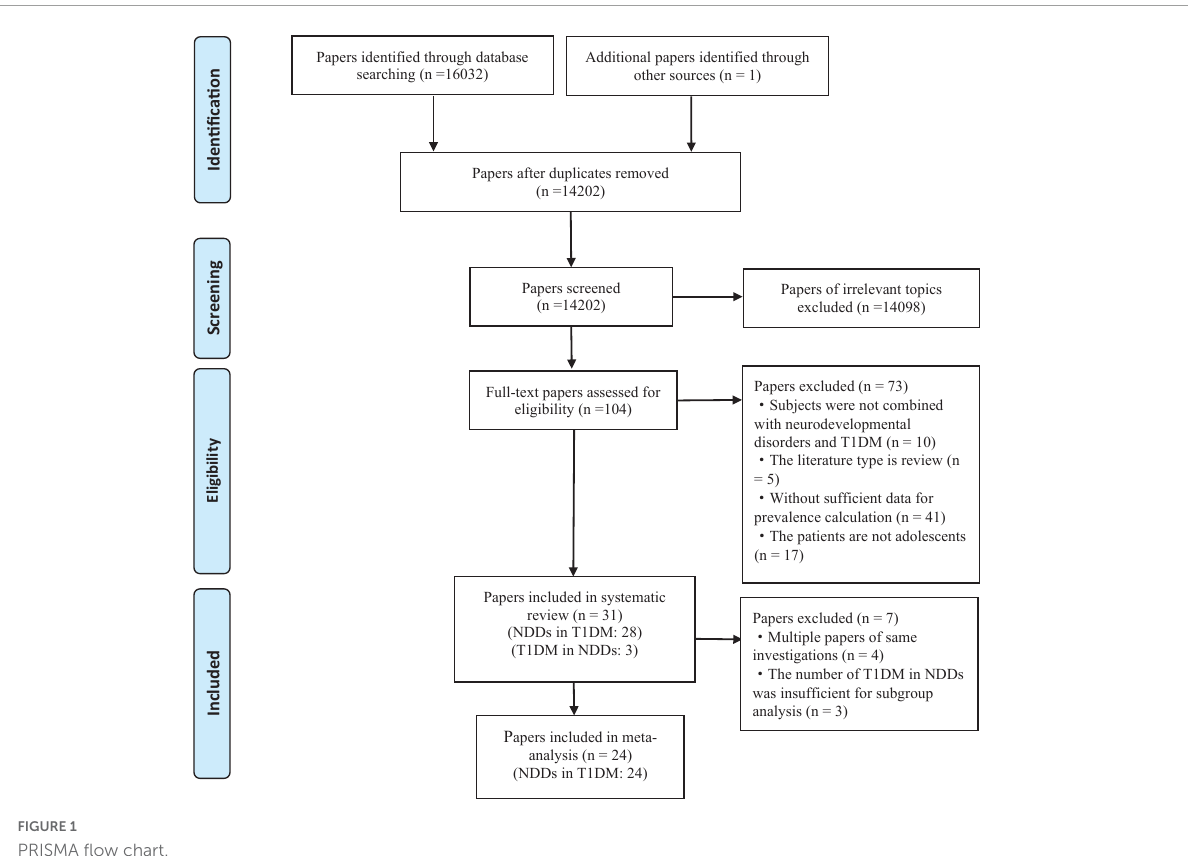
FIGURE1 PRISMA flow